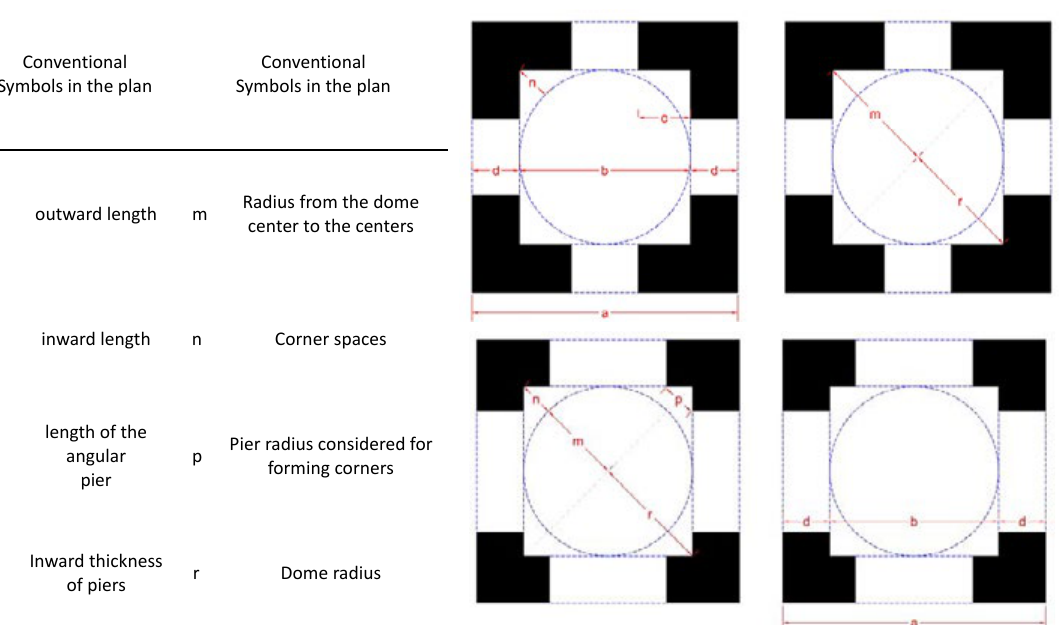
Table 1: Specifications in a square dome plan designated by conventional symbols